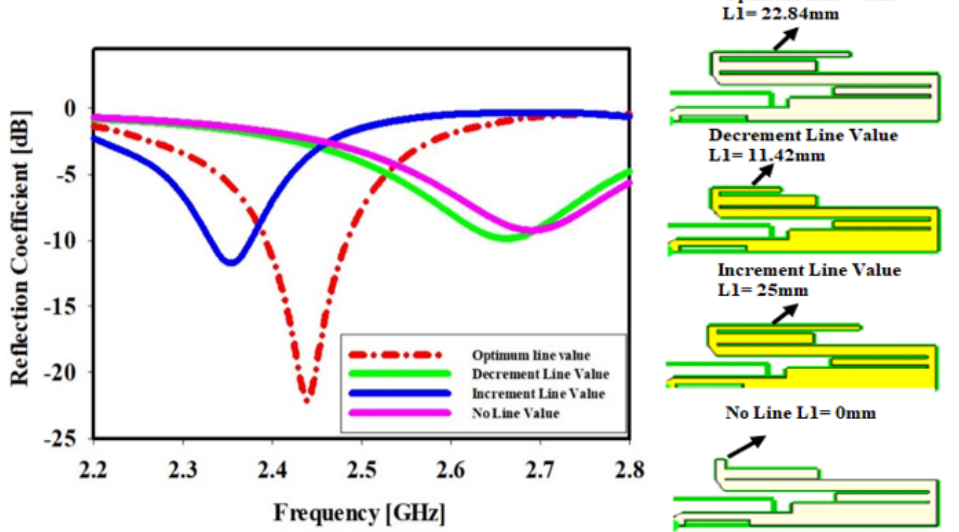
Figure 4. Upper meander line length effect, the sketches on the most − right side in Figure 4 show the geometries of the meander line changes.